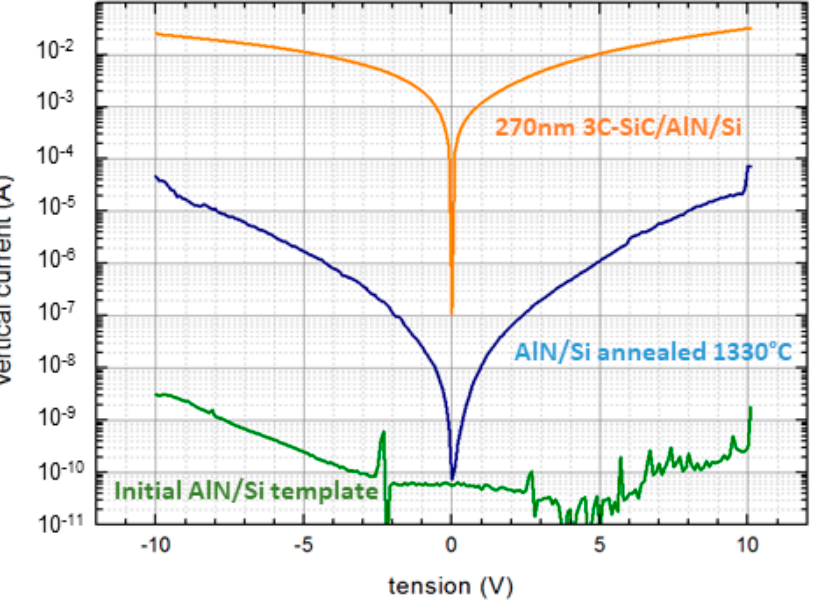
Figure 6. Top to bottom: vertical I(V) measurement on a 3C-SiC/AlN/Si(111), annealed AlN/Si, and non-annealed, as grown, AlN/Si.